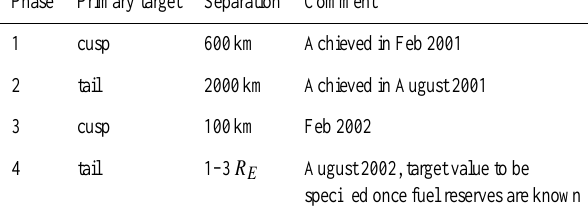
Table 2. The eleven Cluster instruments and their Principal